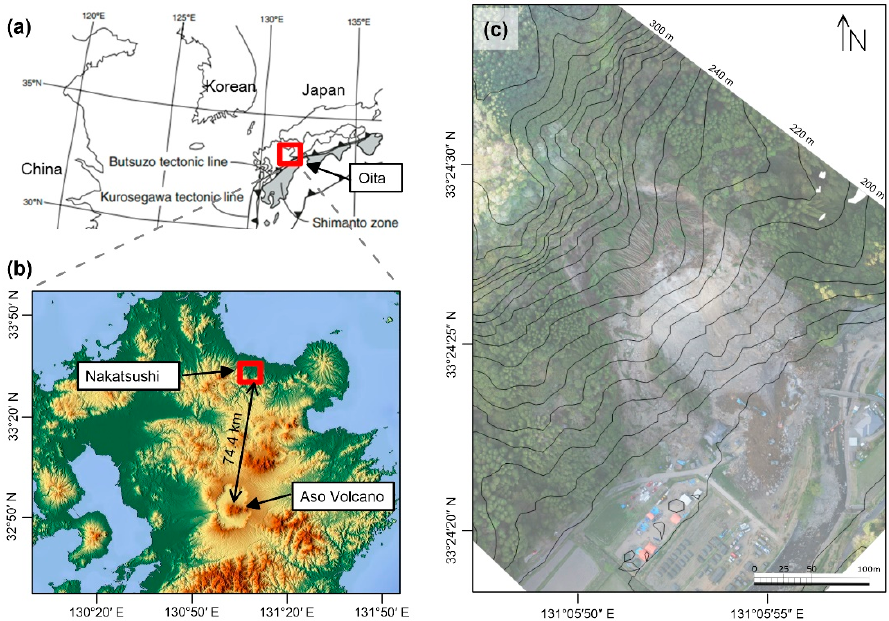
Figure 1. Location and description of the 2018 Yabakei landslide event. ( a ) Location of Oita Province. ( b ) Location of Nakatsu city. ( c ) Overview of the landslide event.